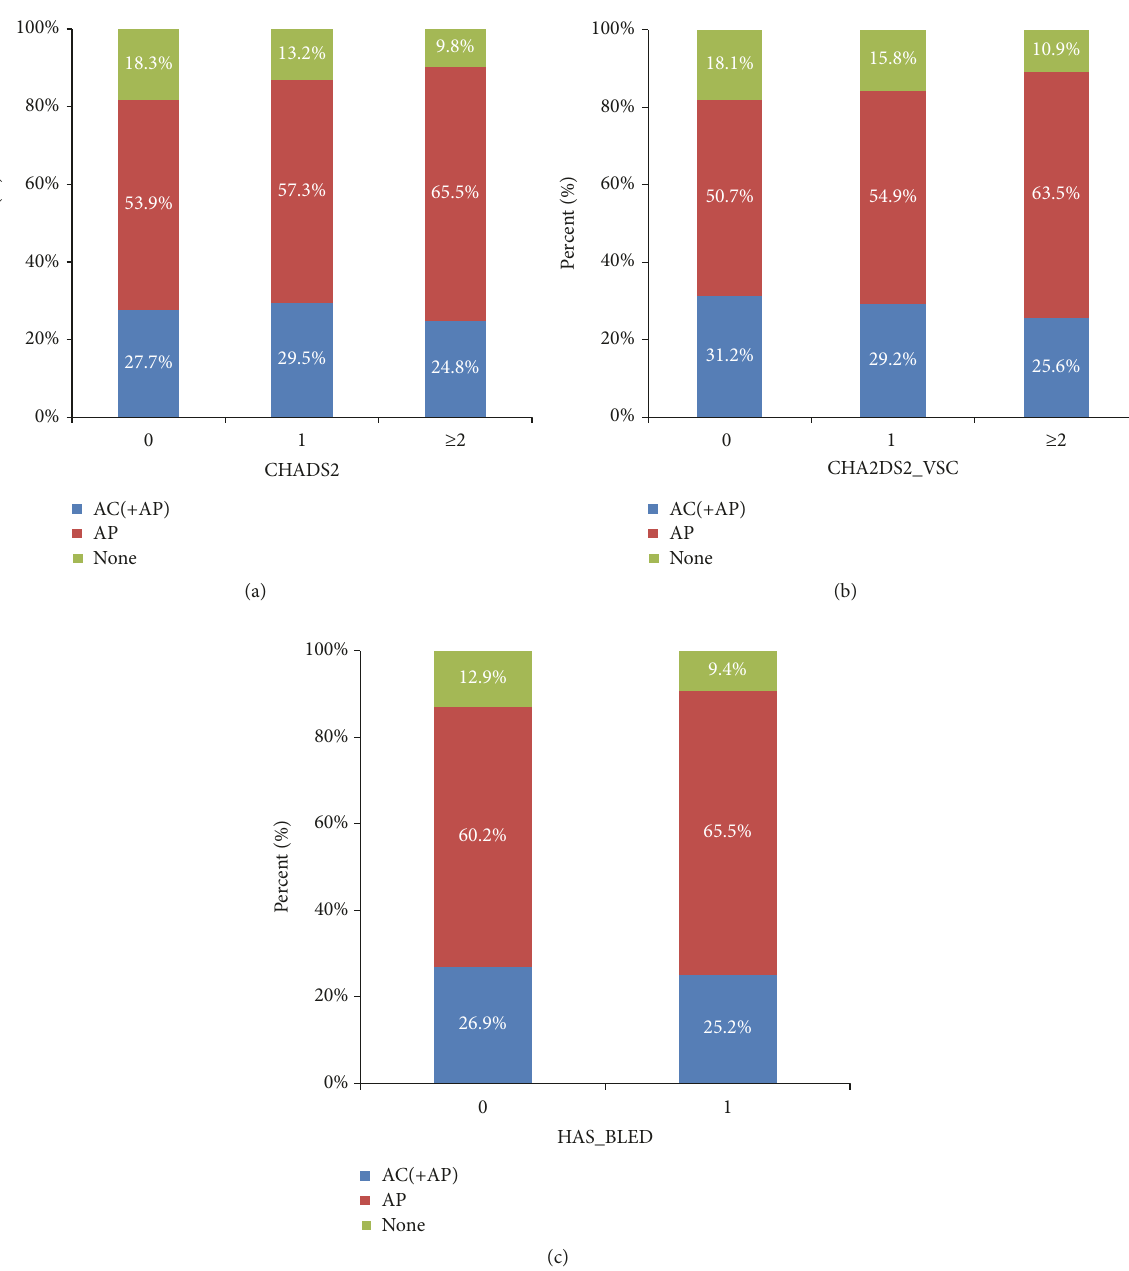
Figure 1: Antithrombotic treatment therapies in patients with nonvalvular atrial fibrillation according to CHADS 2 , CHA 2 DS 2 -VASc, and HAS-BLED scores (AC: anticoagulants; AP: antiplatelet